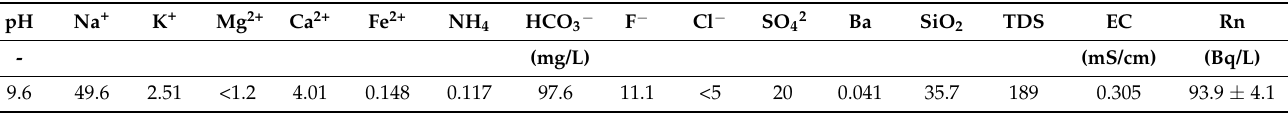
Table 3. Principal components and physical parameters of the geothermal water from LZT-1 (2019) (based on [72]).